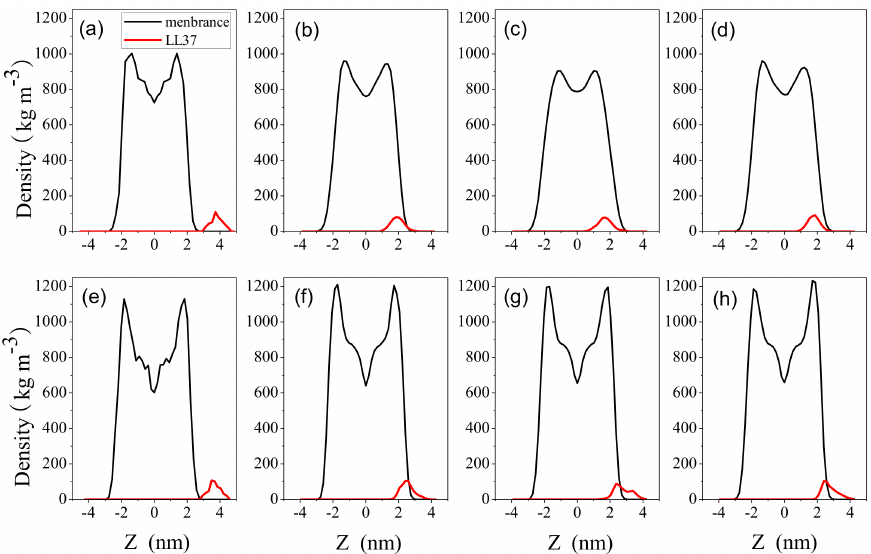
Figure 5. The mass densities of LL-37 in the presence of POPG ( a – d ) and POPC ( e – h ) as a function of distance from the membrane center (z = 0). ( a , e ) were obtained from the initial conformations for POPG and POPC, respectively. All others were derived from the last 100-ns simulation trajectories for three independent simulations. The data was calculated by the program’ g_density’ from GROMACS suite.